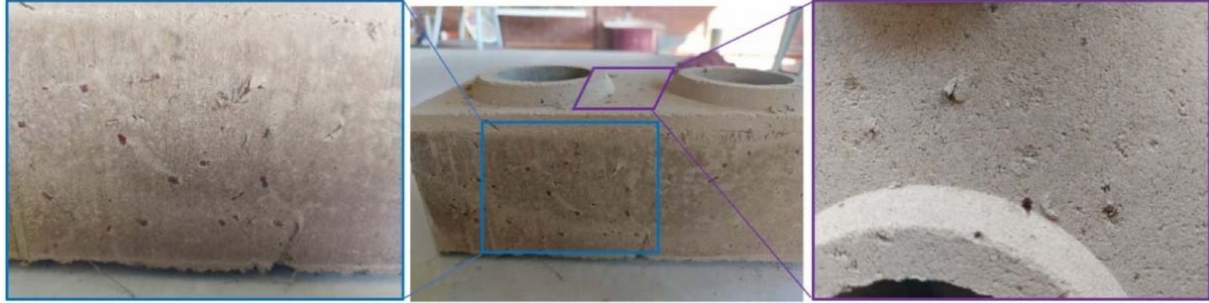
Figure 5. WTSF soil–cement block